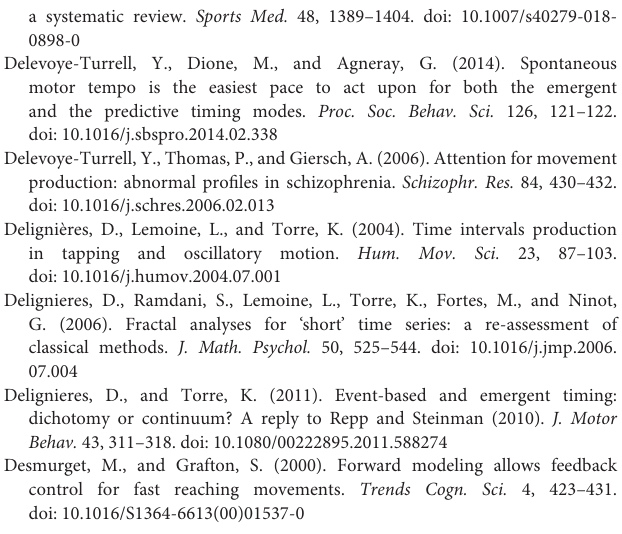
Supplementary Figure 1 | Graphical illustration of the effects of motor tempo on attention ressources required when executing simple or complex spatio-temporal motor tasks. Human individuals may experience contrasting psychological states as a function of the time constraints set upon motor